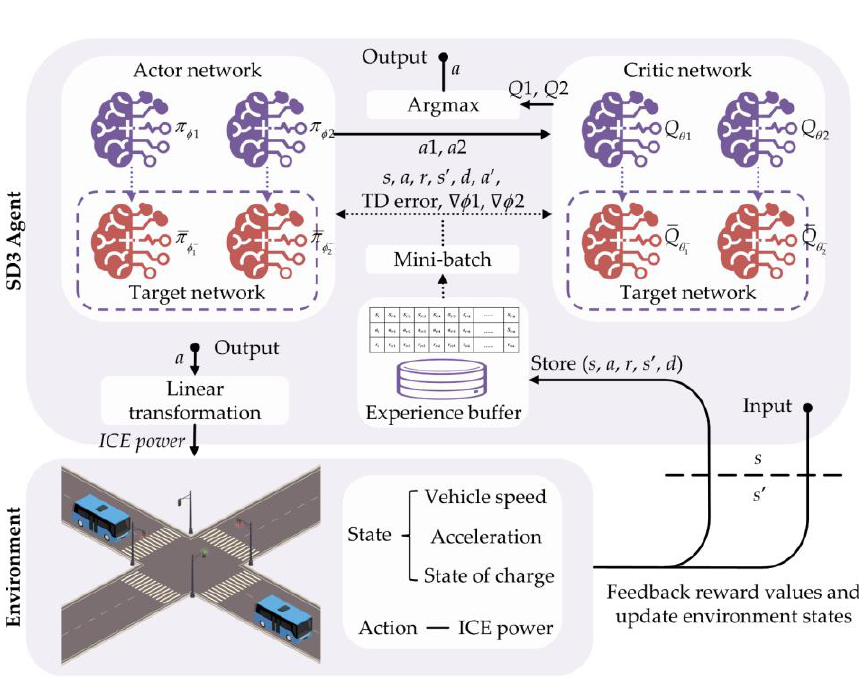
Figure 4. The framework of the SD3-based EMS.